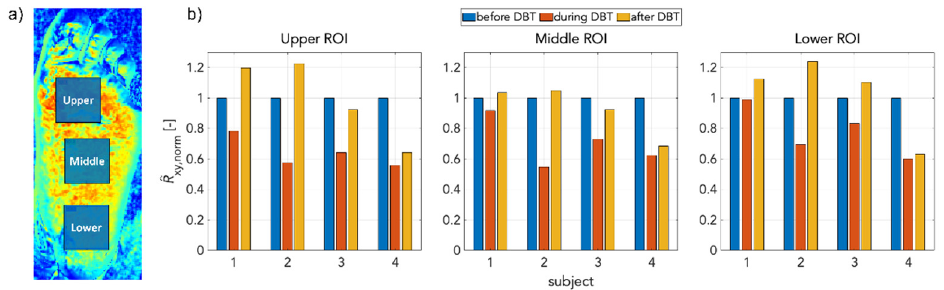
Figure 7. ( a ) correlation map with marked regions (Upper, Middle, Lower); ( b ) Bar graphs with normalized values of correlation coefficients from marked regions for comparison of the perfusion changes in different stages of the experiment.